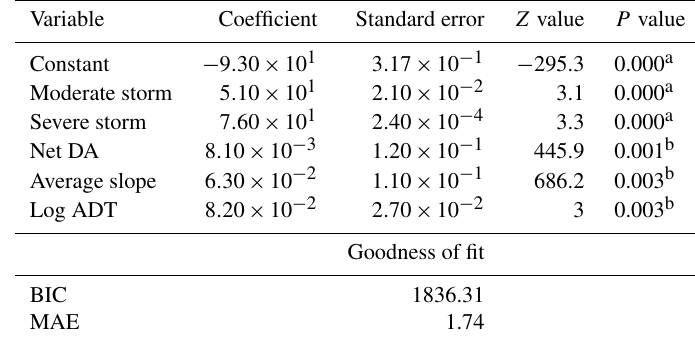
Table 4. NB model estimation results.